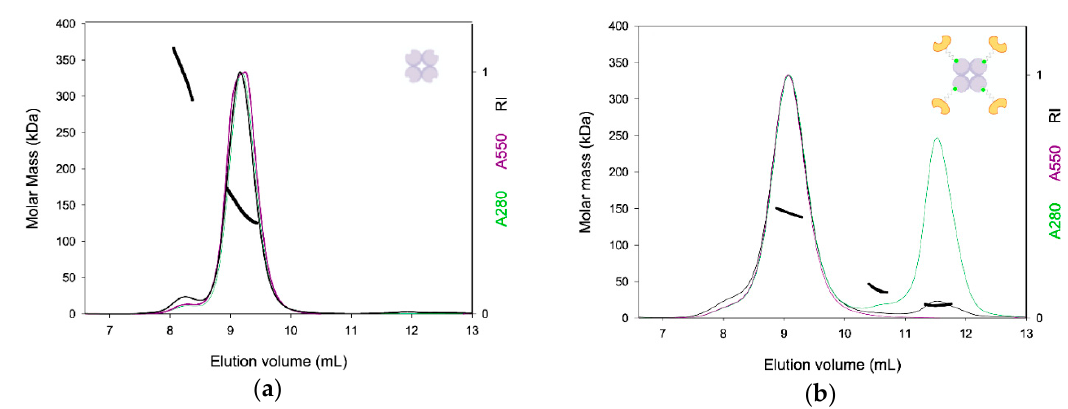
Figure 3. SEC-LS analysis of NeutrAvidin and TETRALEC. NeutrAvidin ( a ) and TETRALEC ( b ) normalized chromatograms at 280 nm (green), at 550 nm (purple), refractive index (RI) changes (black), and molar mass (thick lines) along the elution profiles. Molar masses were determined by combining refractive index and light scattering.